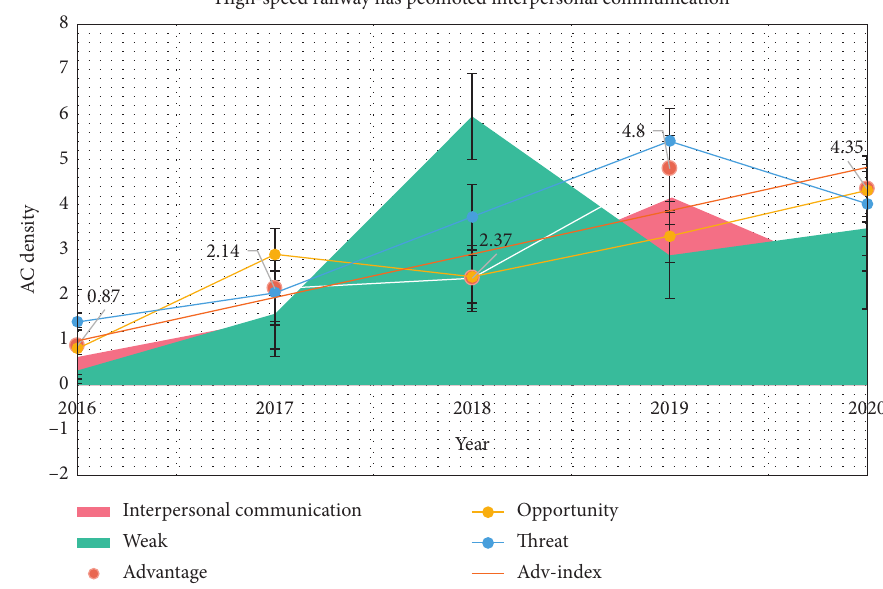
Figure 10: High-speed railway has promoted interpersonal